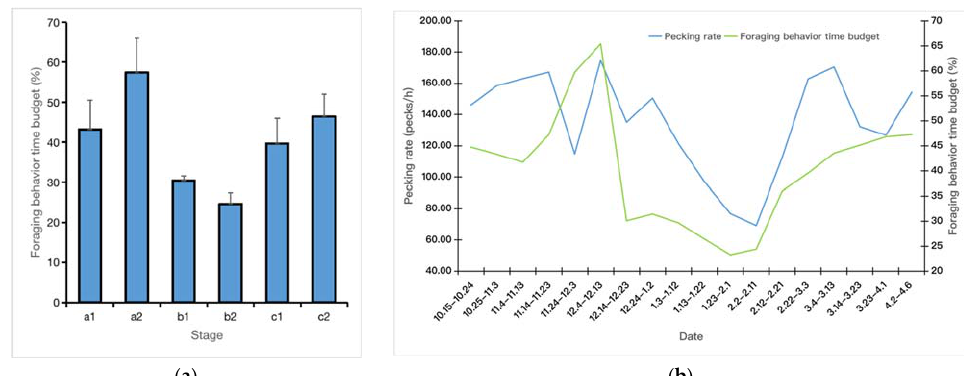
Figure 3. Dynamic changes in the pecking rate and foraging behavior time budget of the greater white-fronted geese at Shengjin Lake. ( a ) Changes in the foraging behavior time budget; ( b ) dynamic changes in the pecking rate and foraging behavior time budget showed a bimodal distribution trend. (a1 and a2—Early Winter, b1 and b2—Middle Winter, c1 and c2—Late Winter).